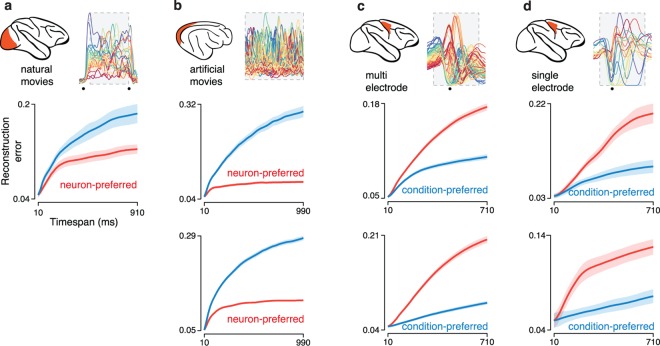
Preferred-mode analysis across neural populations.Each panel corresponds to a dataset type, and plots normalized reconstruction error as a function of timespan (as in Fig 3C and 3E). Excepting panel a, two datasets corresponding to two animals were analyzed, yielding two plots per panel. Insets at top indicate the dataset type and show the response of an example neuron. (a) Analysis for the V1 population from Fig 1A, recorded from a monkey viewing movies of natural scenes. Data are the same as in Fig 3C and are reproduced here for comparison with other datasets. (b) Analysis of two V1 populations recorded from two cats using grating sequences. (c) Analysis of two M1 populations (monkeys J and N) recorded using implanted electrode arrays. The top panel corresponds to the dataset illustrated in Fig 1B and reproduces the analysis from Fig 3E. (d) Analysis of two additional M1 populations from the same two monkeys but for a different set of reaches, with neural populations recorded sequentially using single electrodes.